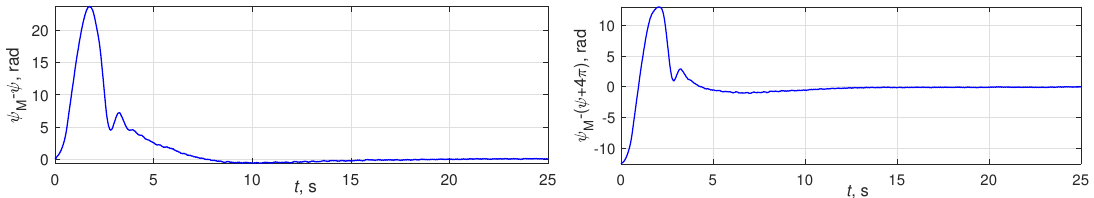
Figure 8. Experiment. IMR output error ε ψ ( t ) = ψ M ( t ) − ψ ( t ) time history for ψ ∗ = π . Linear error ( left plot ), sine-modification ( right plot ).